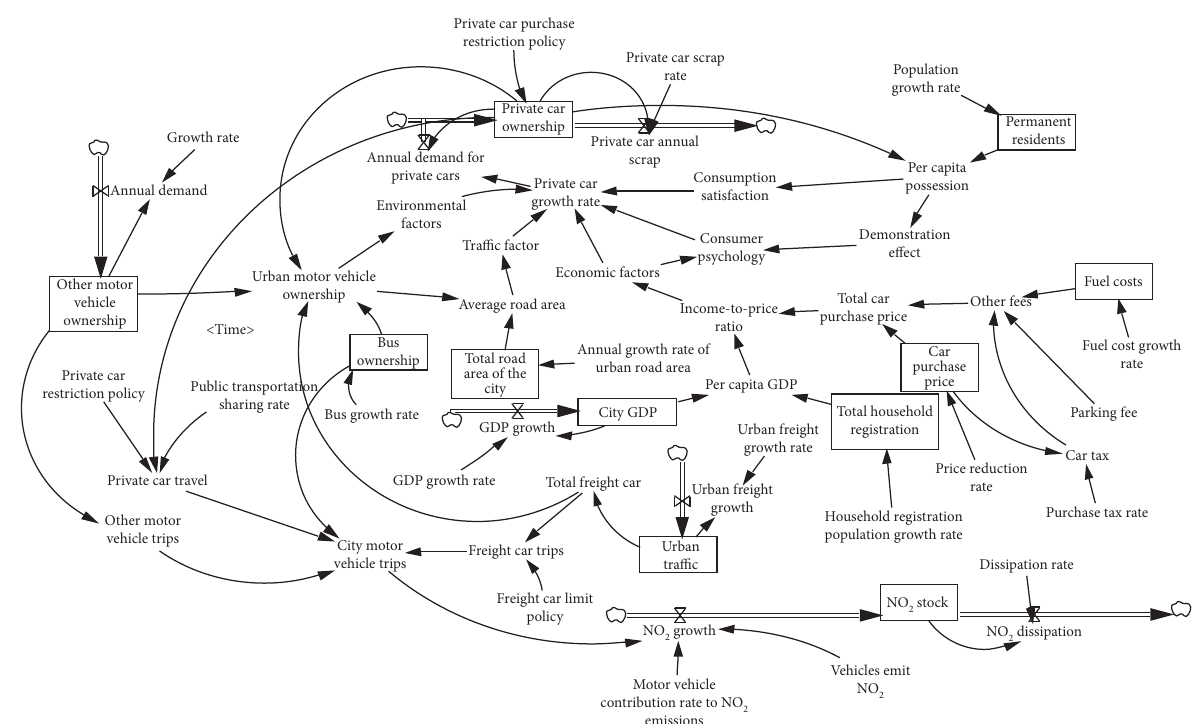
Figure 4: System dynamics diagram (with policy).